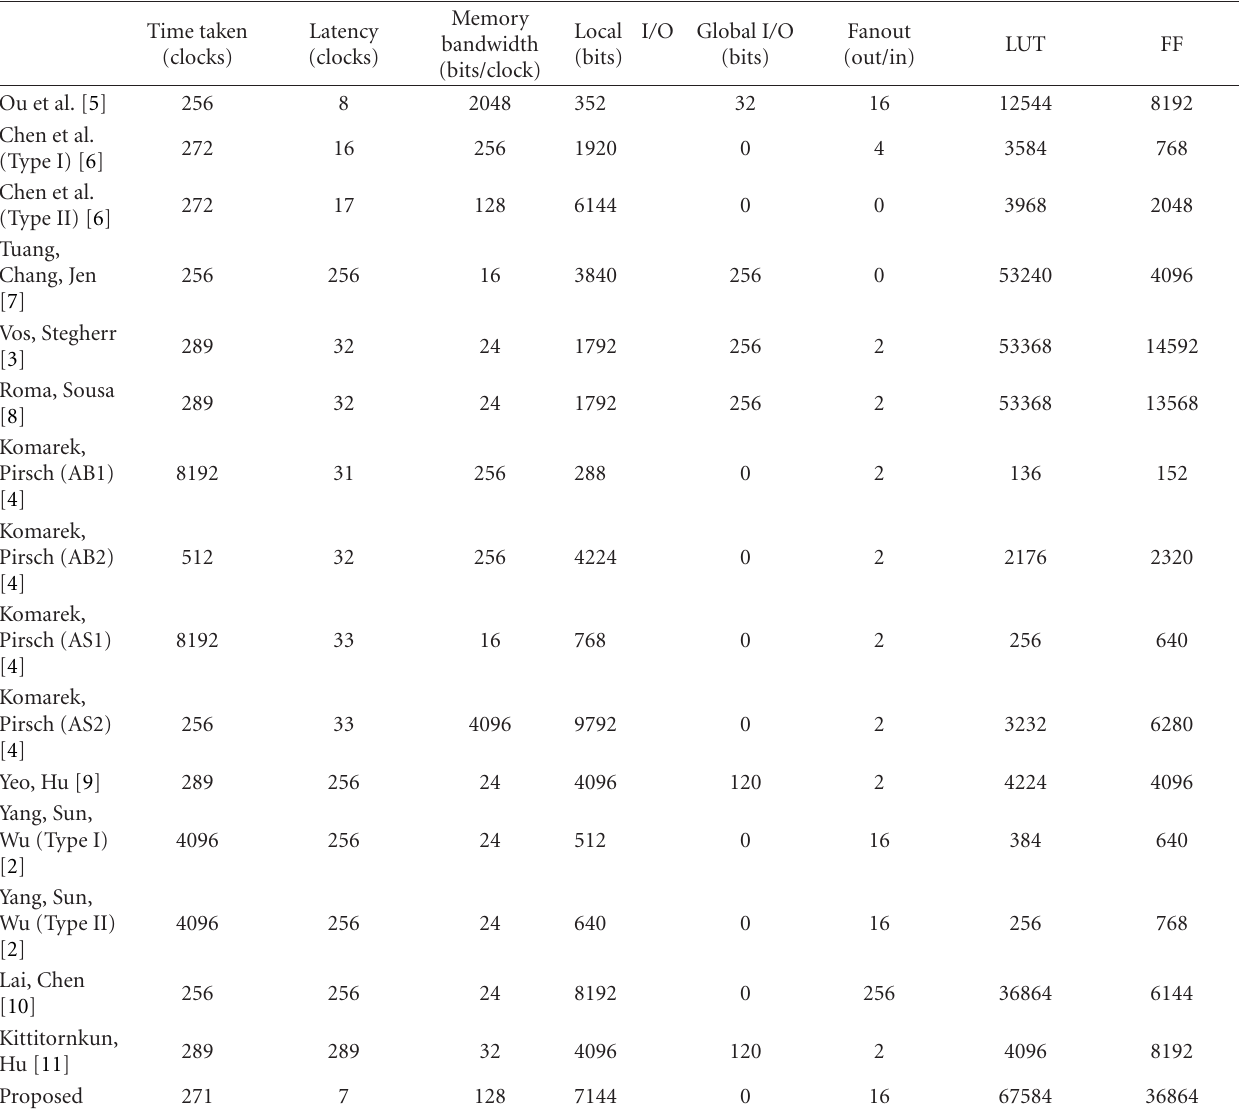
Table 6: Evaluation of proposed architecture against all related motion estimation architectures (time taken represents number of clock cycles for computing 16 4 × 4